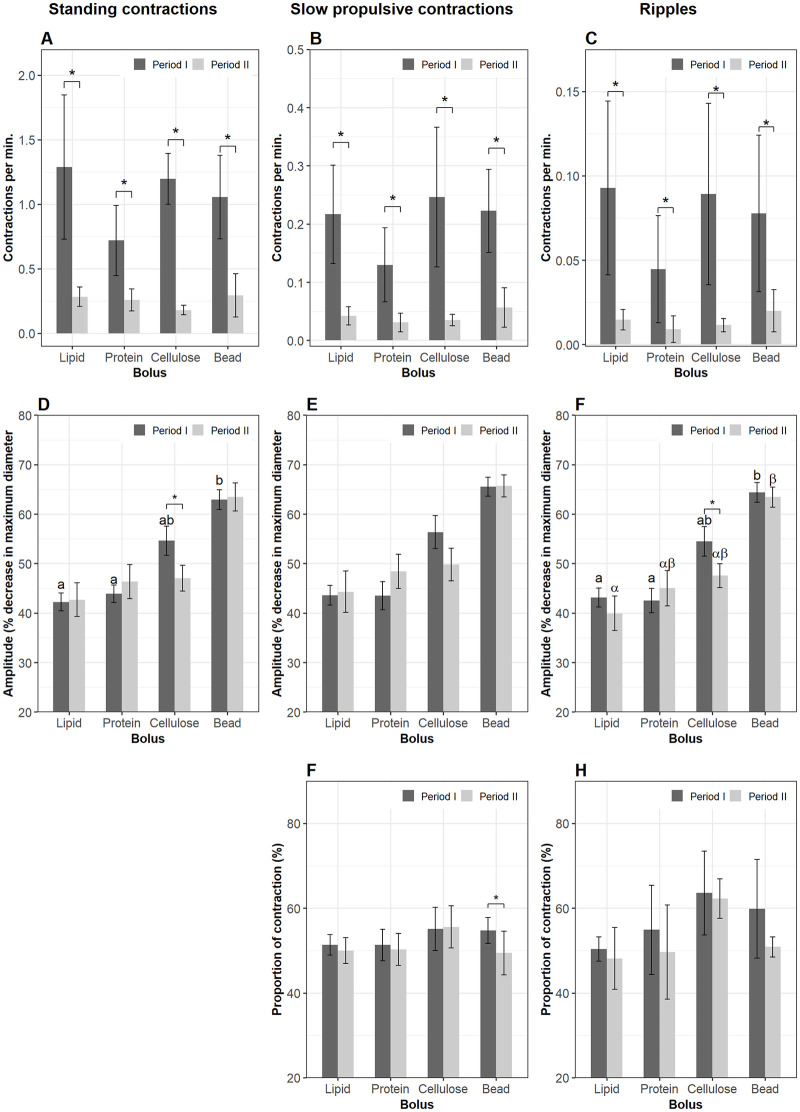
Motility parameters in Segment 2.Contractions were analyzed in Segment 2 of the intestines when a bolus (lipid, protein, cellulose or plastic bead) was administered (period I) and after the bolus evacuated Segment 1 (period II). Frequency (mean±s.d.) of standing contractions (A), slow propulsive contractions (B) and ripples (C). Amplitude (median±s.e.m.) of standing contractions (D) and ripples (E). Proportion (mean±s.d.) of slow propulsive contractions (F) which propagate to an antegrade direction. Significant differences (p < 0.05) between the four bolus treatments within period I are annotated by Latin letters and differences within period II by Greek letters. Asterisks and brackets show a significant difference (p < 0.05) between periods. Data were analyzed using linear mixed-effects models—lme test followed by Tukey HSD in R for (A–C); Generalized Linear Mixed Models via PQL—glmmPQL test for (D–F), with n = 11 for lipid, n = 12 for protein, n = 6 for cellulose or plastic bead.